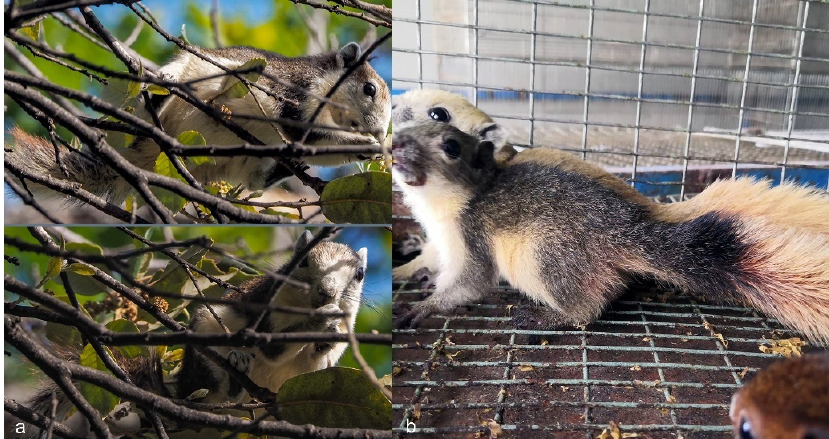
Table 1. Summary of the number of releases (introductions and translocations) of Callosciurus squirrels in the world. Country